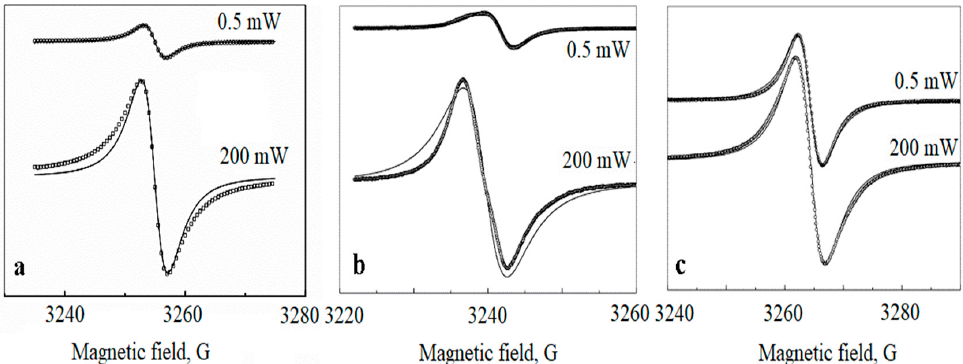
Figure 3. Room temperature EPR spectra of Pd nanoparticles in polyethylene matrix for different metal content: 5 wt.% ( a ), 10 wt.% ( b ), 20 wt.% ( c ). The spectra for low and high microwave power values (0.5 mW and 200 mW) are shown. The solid lines are fitting Lorentzians, the circle (light) lines are the experimental curves.